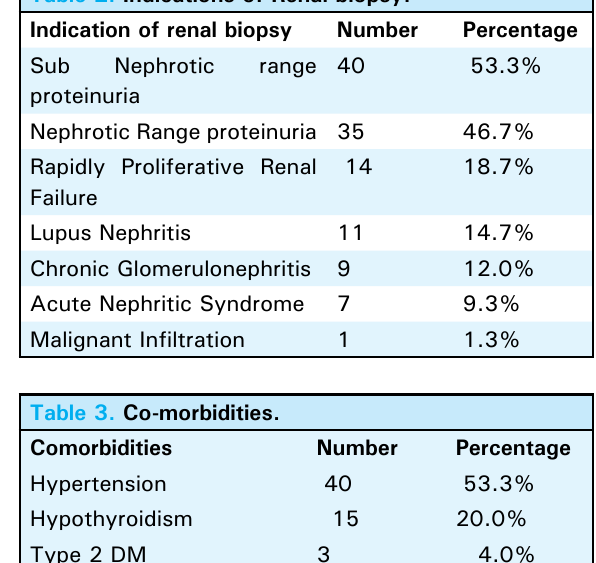
table 2. Indications of renal biopsy.